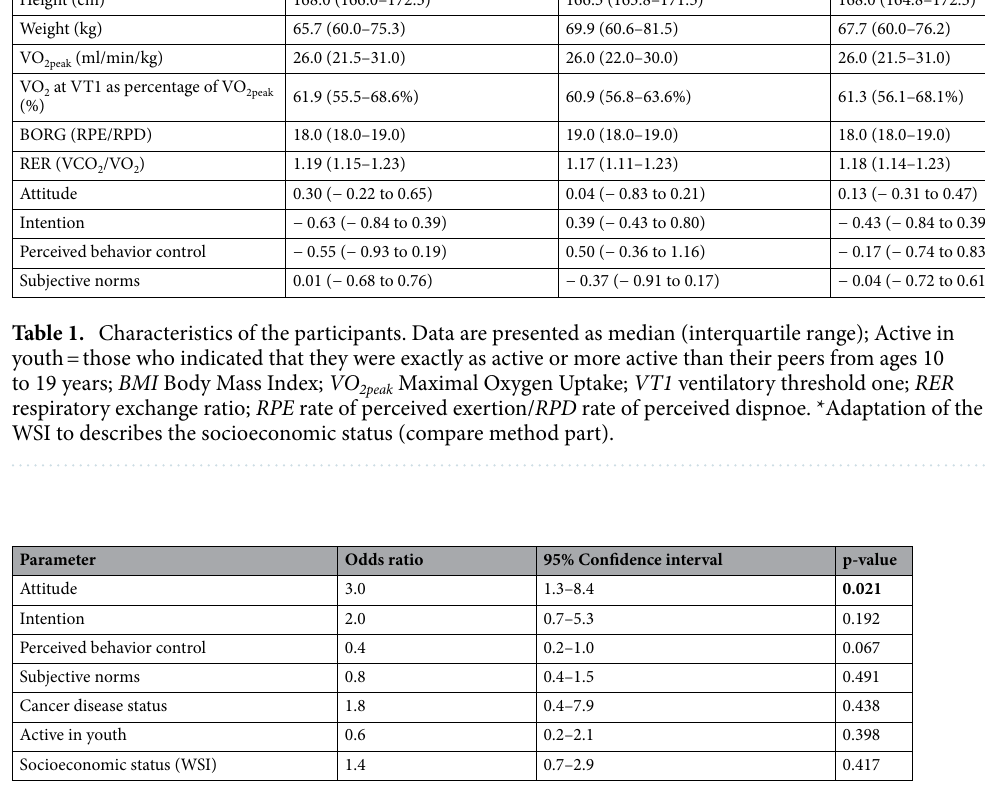
Table 2. Logistic regression results for predicting the VO 2peak reference value. Active in youth = binary variable indicating whether they were exactly as active or more active than their peers from ages 10 to 19 years. WSI Winkler-Stolzenberg Index to describe the socioeconomic